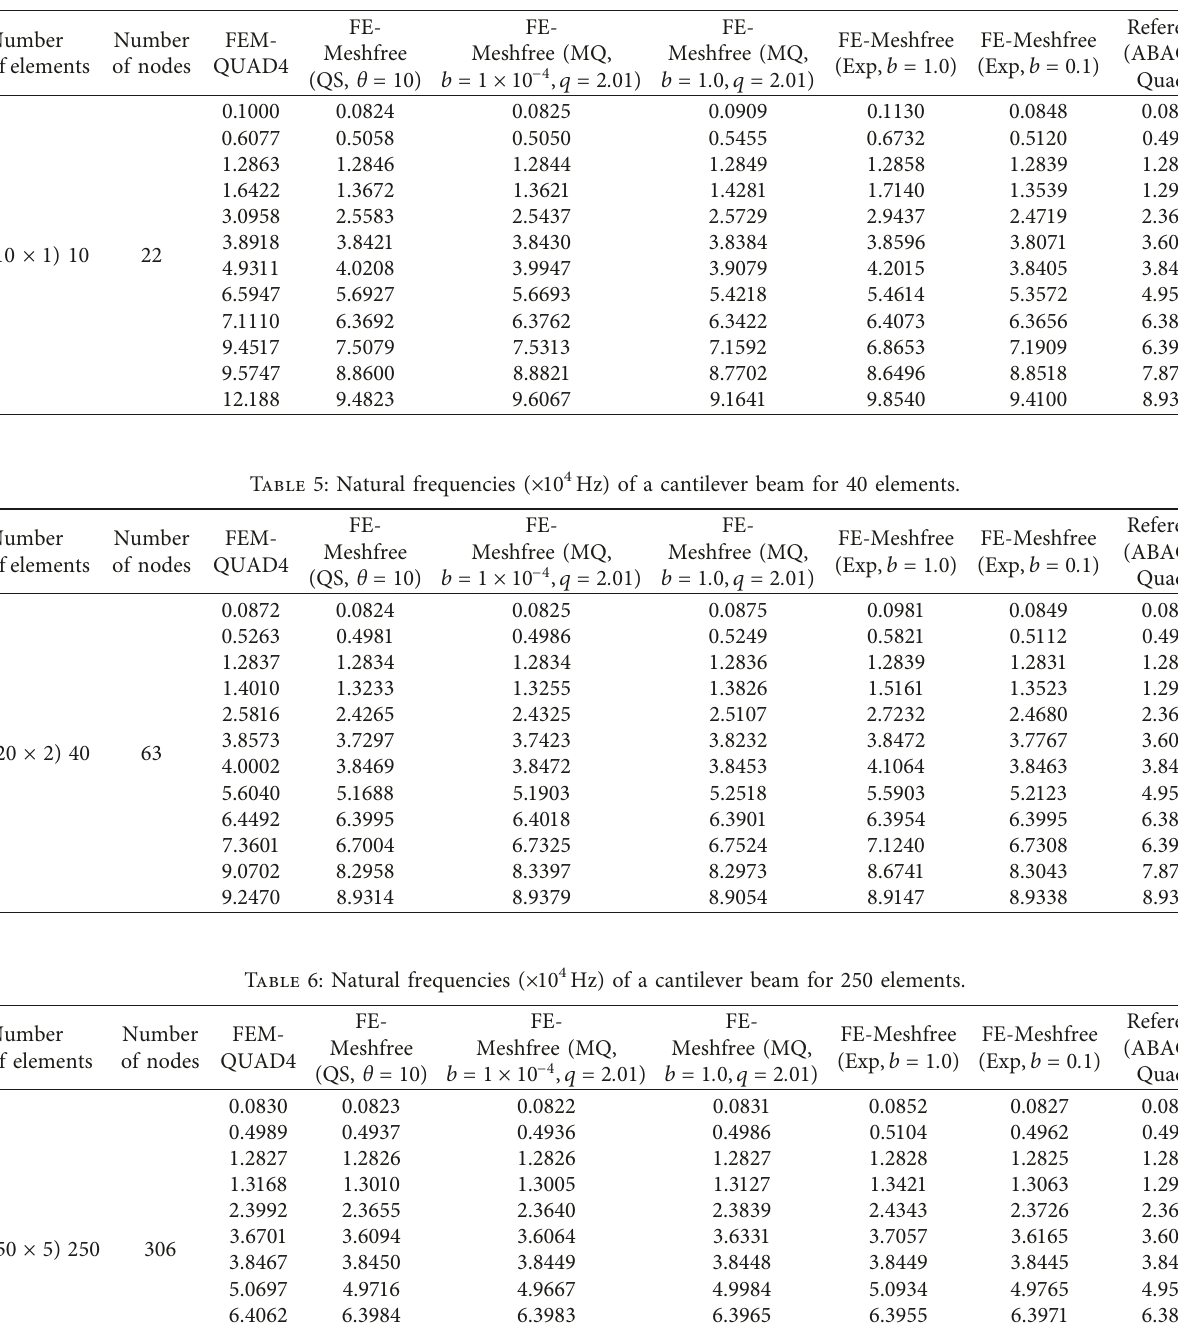
Table 4: Natural frequencies ( × 10 4 Hz) of a cantilever beam for 10 elements.